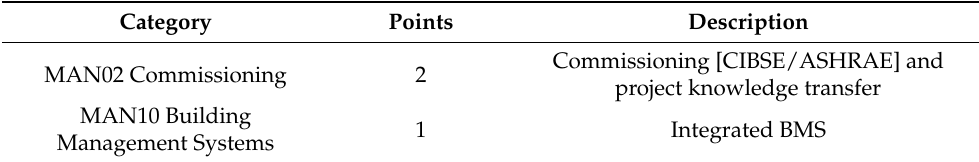
Table 2. Project scorecard EMS College—Management category.